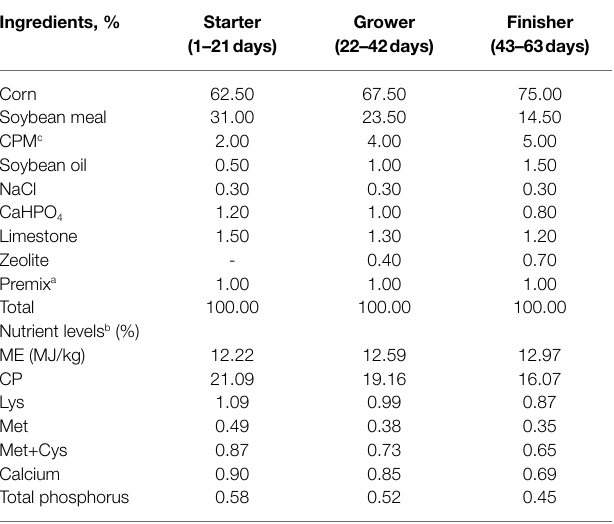
TABLE 1 | Composition and nutrient level of the basal diet used in different phases of trial (% as fed basis). Ingredients,